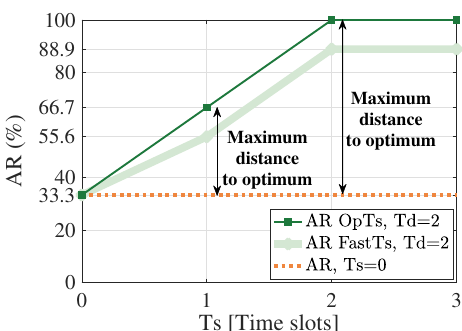
Figure 17. Example to evaluate the difference between O PT T S and F AST T S . Parameters: Case A , AR , = 2 [time slots] for all S and T k k . d